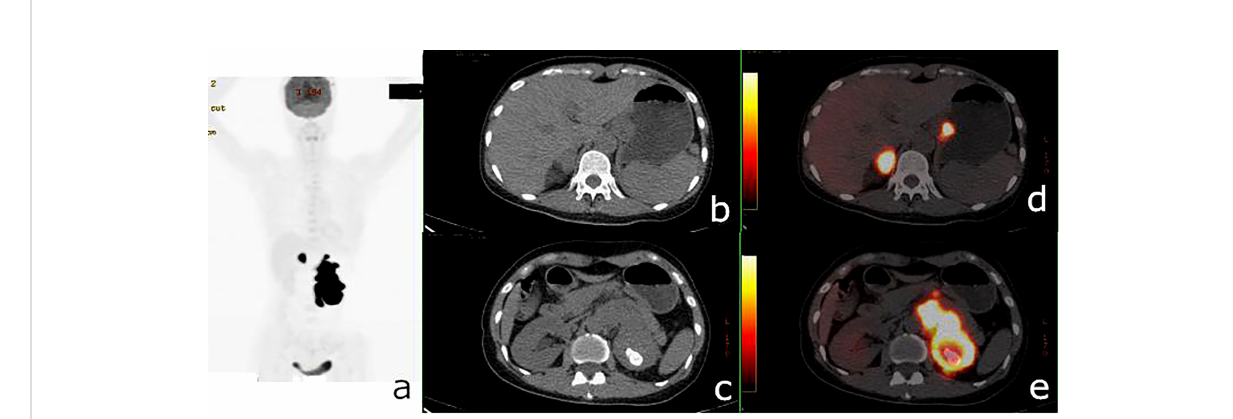
FIGURE 4 18 F- fl uorodeoxyglucose positron emission tomography/computed tomography ( 18 F-FDG PET/CT) of a 50-year-old woman with renal adenocarcinoma and gastric stromal tumor. PET/CT demonstrated an irregular mass in the left kidney with a maximum standardized uptake value (SUV max ) of 45.3 and a 24 × 19-mm nodule in the gastric cardia with SUV max = 28.3. A hypermetabolic right adrenal nodule and several hypermetabolic retroperitoneal lymph nodes were also shown. (A) PET maximum intensity projection (MIP). (B, C) Axial CT. (D, E) Fusion